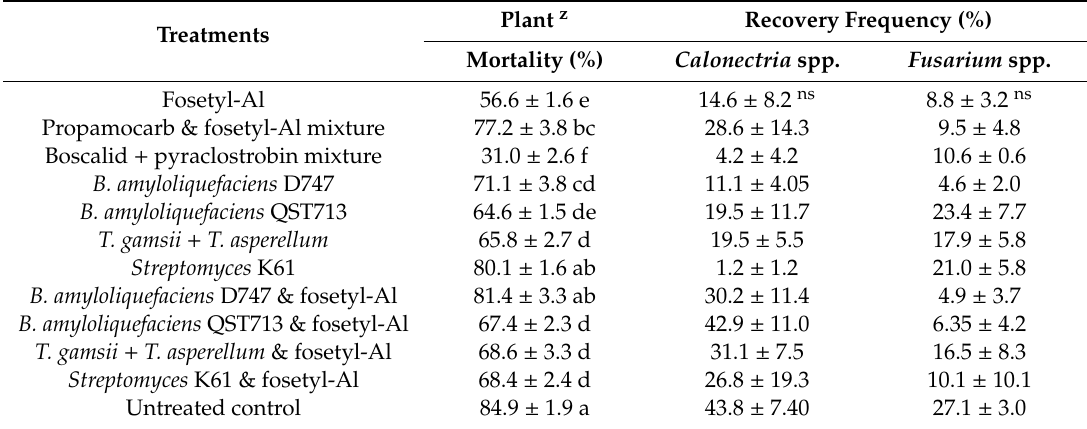
Table 1. E ffi cacy of treatments in reducing milkwort decline in experiment I under artificial inoculation with Calonectria pauciramosa after 4